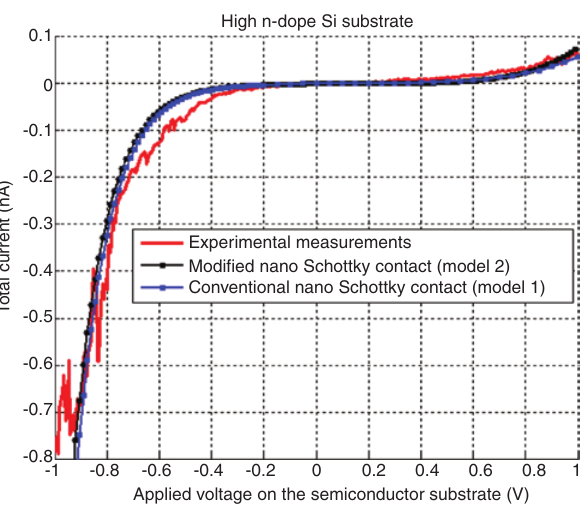
Figure 13: I-V data of the nano-Schottky junction between a nanotip and a high n-doped semiconductor substrate. The data show high contact resistance.